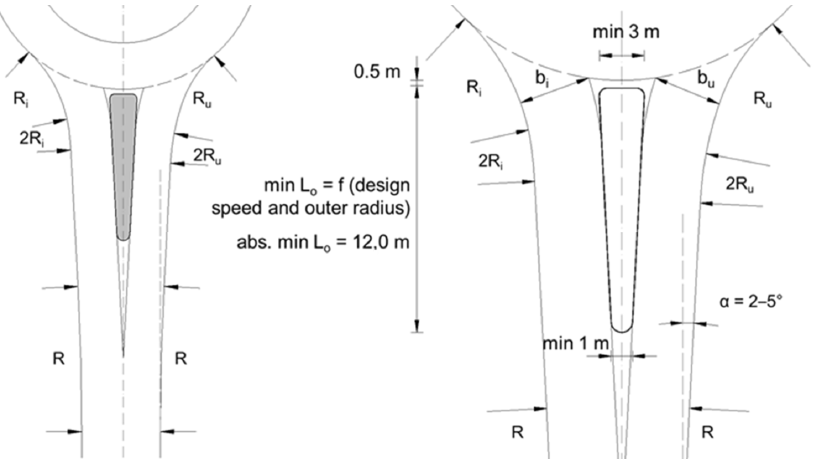
Figure 16. Splitter islands for a medium level of traffic-flow channeling [10].